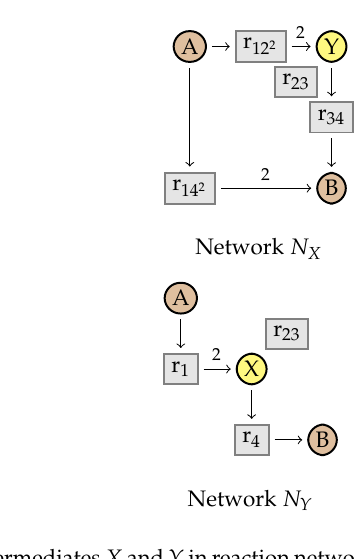
Figure 7. Elimination of intermediates X and Y in reaction network N in both possible orders, leading to two different final results N XY and N YX